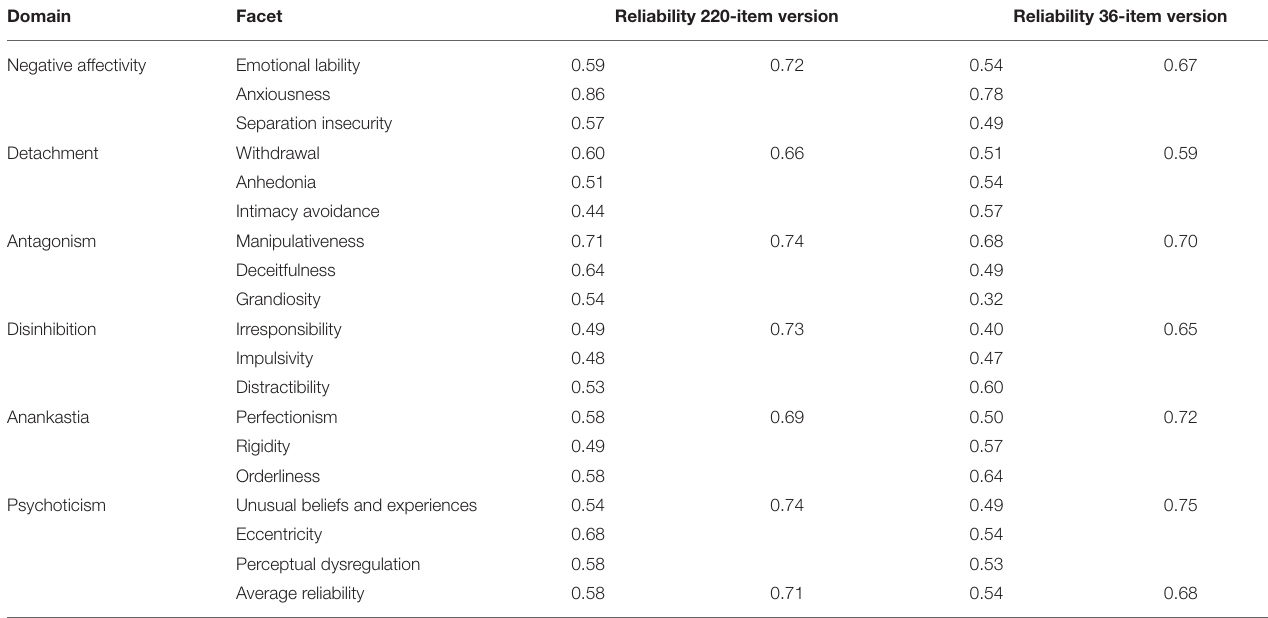
TABLE 4 | Internal reliabilities of PID-5 facets and domains across two versions of PID5BF + M.